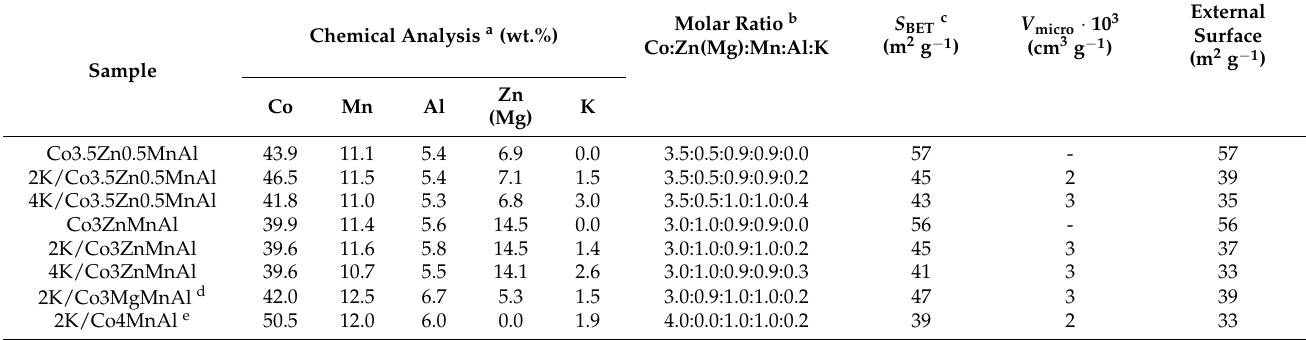
Table 1. Chemical analysis and texture of prepared mixed oxide